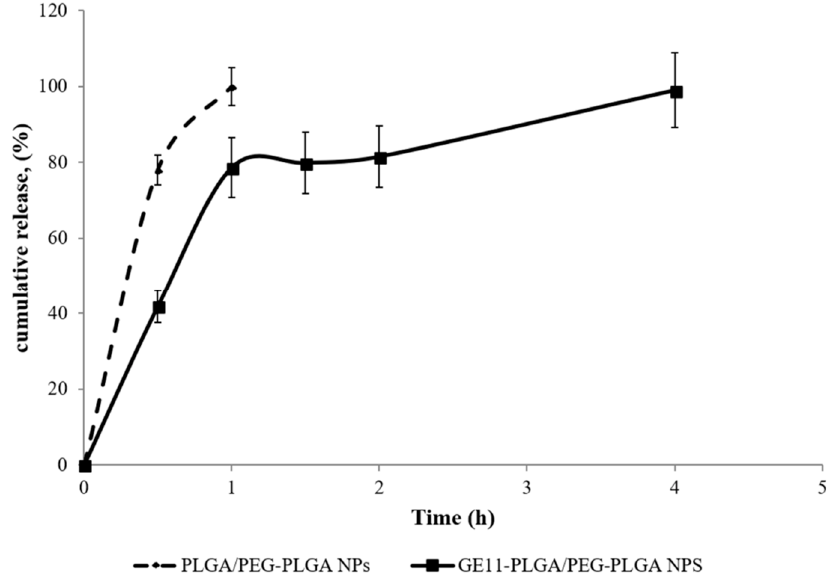
Figure 10. DXM release profile from GE11-PLGA/PEG-PLGA NPs (solid line) and PLGA/PEG-PLGA NPs (dotted line) under simulated inflammatory pathological conditions (pH7.0) at 37 °C.